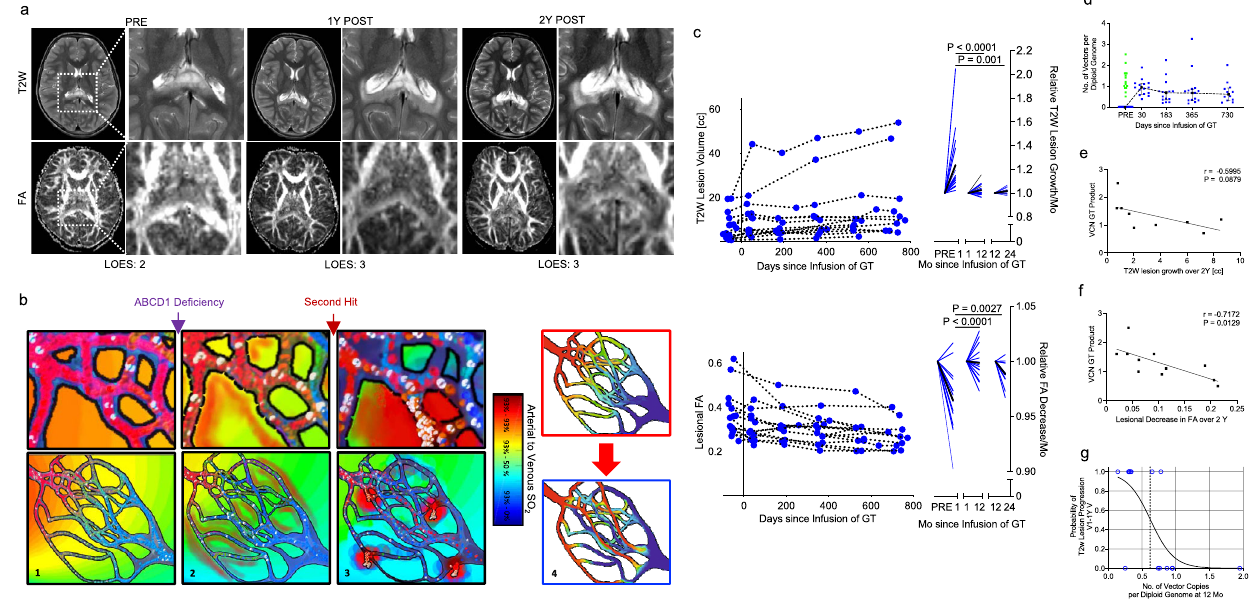
Fig. 1 | Gene dosage and correlations with demyelinating lesion growth in CALD. a Representative images of T2-weighted (T2W) and fractional anisotropy (FA) maps of a patient with CALD before (PRE), 1 and 2 years post successful gene therapy(GT).Magni fi cationsillustratetheprogressoftheT2Wlesionandstructural tissue reorganization on FA maps primarily within the fi rst year and only minor changesinthesecondyear. b Schematicillustrationsofmicrovascularvulnerability causedby ABCD1 de fi ciency.Lossof ABCD1 functioninhemizygotesleadstoaltered interactions of leukocytes and brain-endothelium. Compared to healthy fl ow con- ditions (1), this causes increased fl ow heterogeneity and BBB-permeability within capillarybeds(2)andprecedesconversiontoCALDexacerbatedbyayetunknown “ second hit ” (red). As the CALD manifests, fl ow heterogeneity and BBB- permeability exacerbate (3). The degree of leukocyte-to-brain-endothelial cell interaction is thought to affect microcirculation causing fl ow disturbances and shuntinginthecapillarybed,impairingvascularef fi cacy(4). c Longitudinaldatafor T2W lesion volume (top) and mean lesional FA (bottom) of GT-treated patients ( n =15).Foreachrowleft,diagramshowsthelongitudinalcourseandrightdiagram